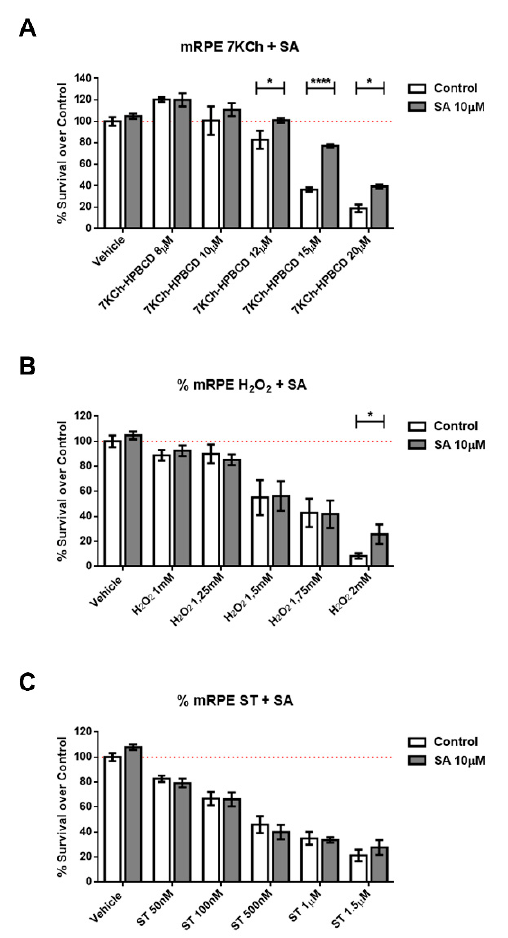
Figure 2. Protective e ff ect of SA in di ff erent cell death models in mRPE retina cells. Cell survival in mRPE cell cultures was measured by the MTS method. ( A ) Protective e ff ect over dose-dependent 7KCh-HPBCD cell death. ( B ) Protective e ff ect over dose-dependent H 2 O 2 oxidative stress injury. ( C ) Protective e ff ect over dose-dependent caspase-3 dependent staurosporine cell death. Data are presented as mean ± SEM of 12-well plates of at least four di ff erent experiments. * p < 0.05, **** p < 0.0001. Red dashed line is a guidance mark of 100% of viability in control cells.